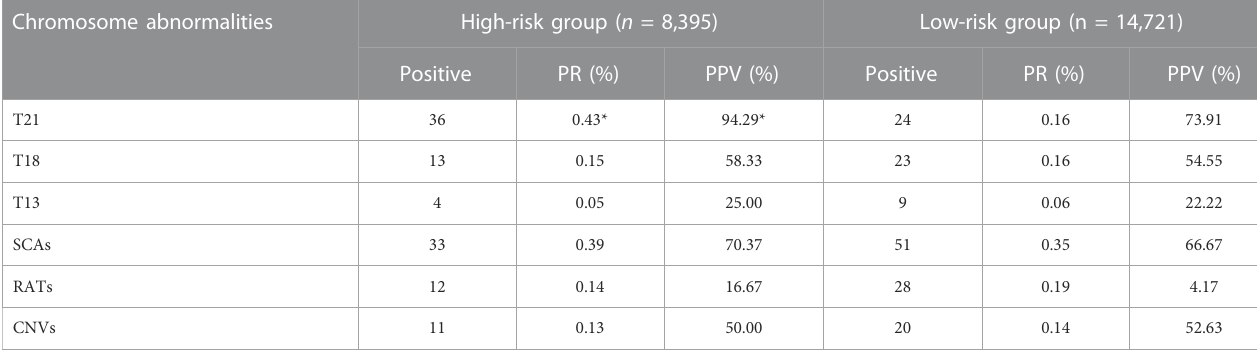
TABLE 5 Pregnancy outcome of con fi rmatory abnormal fetuses and positive screening cases without prenatal diagnosis. Chromosome abnormlities Ture positive (karyotyping or